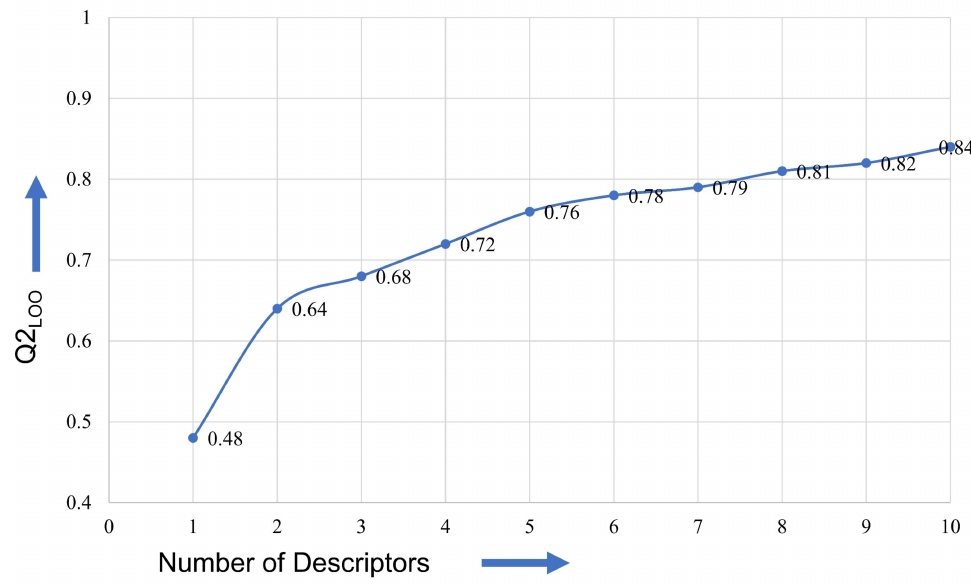
Figure 12. Plot of number of descriptors against leave-one-out coefficient of determination, Q 2 LOO , to identify the optimum number of